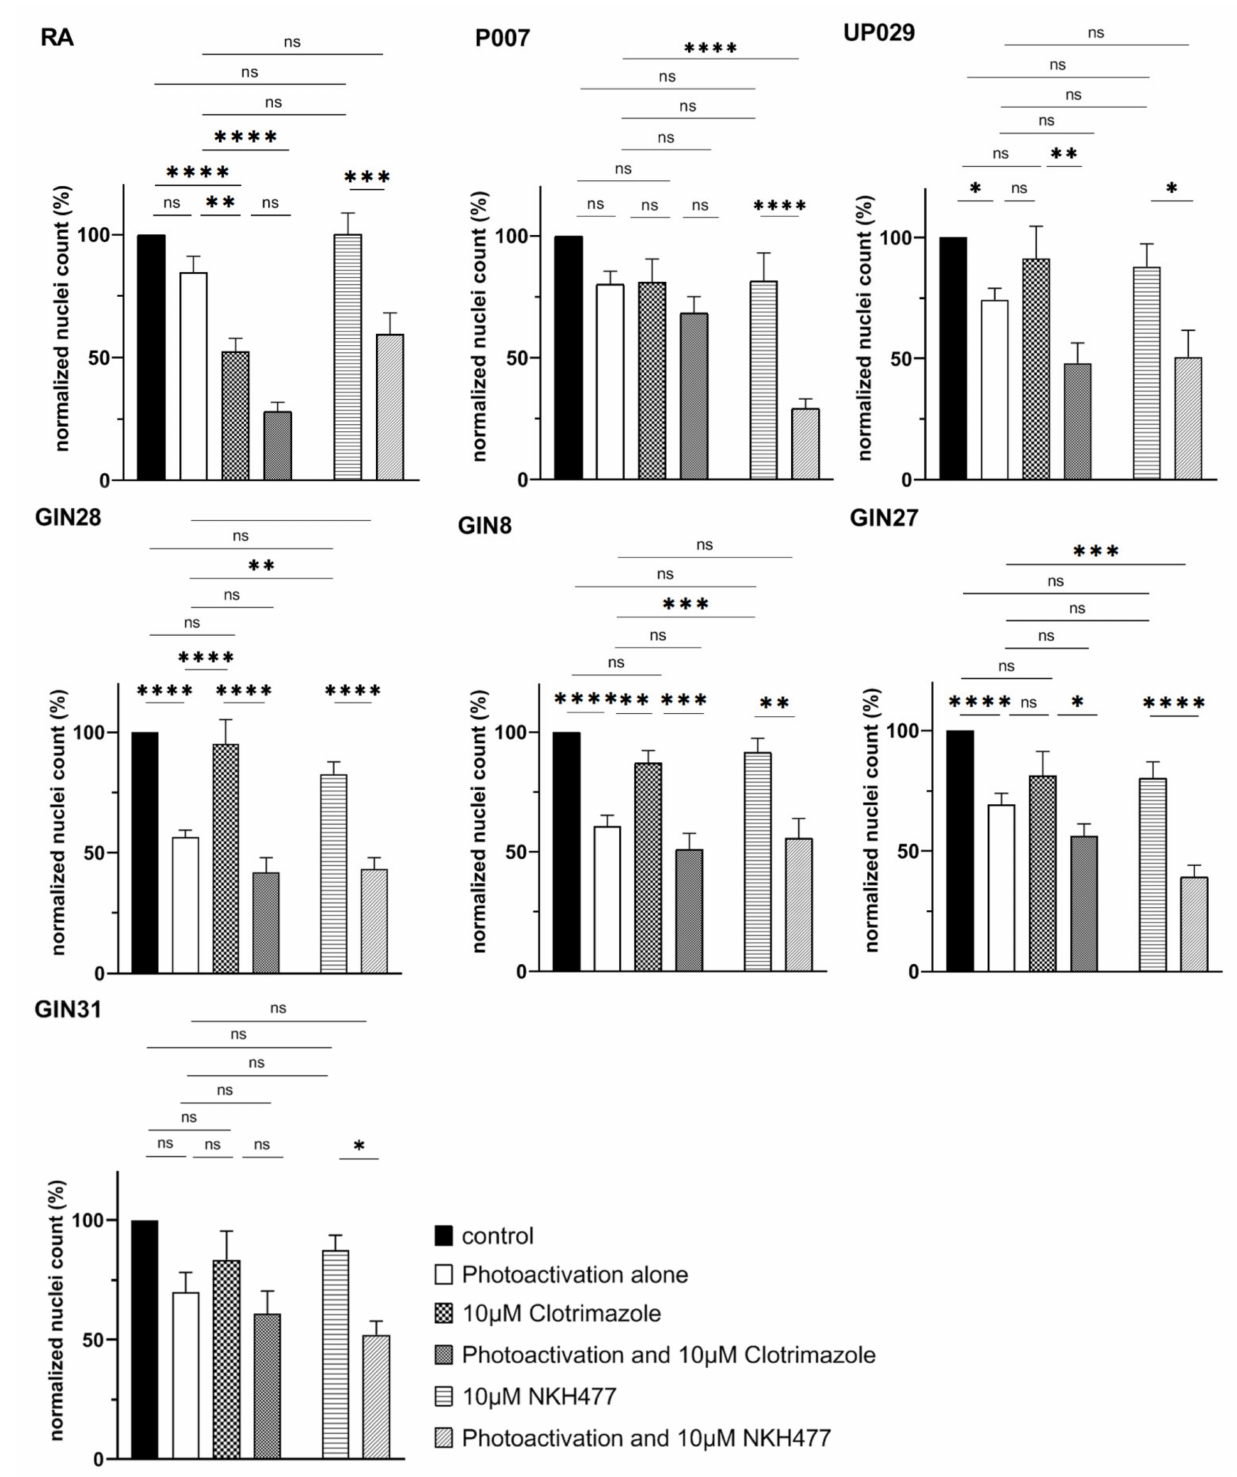
Figure 10. Synergistic effect of a low-dose NKH477 pre-treatment plus sub-lethal photoactivation (20 s) of TMRM-loaded GBM cells resulted in a significant decrease in the viability of some GBM cell lines (in UP007 and GIN27) compared to the controls or treatment with NKH477 alone or TMRM-PDT alone. No significant effect of clotrimazole after TMRM-PDT was observed. The number of independent experiments is: 5 for RA, 4 for UP007, UP029, GIN8, and GIN28 cells and 3 for GIN27 and GIN31 cells—all in duplicates. (ns) p > 0.05, (*) p < 0.033, (**) p < 0.002, (***) p < 0.0002, (****) p < 0.0001, alpha = 0.05. ns—not